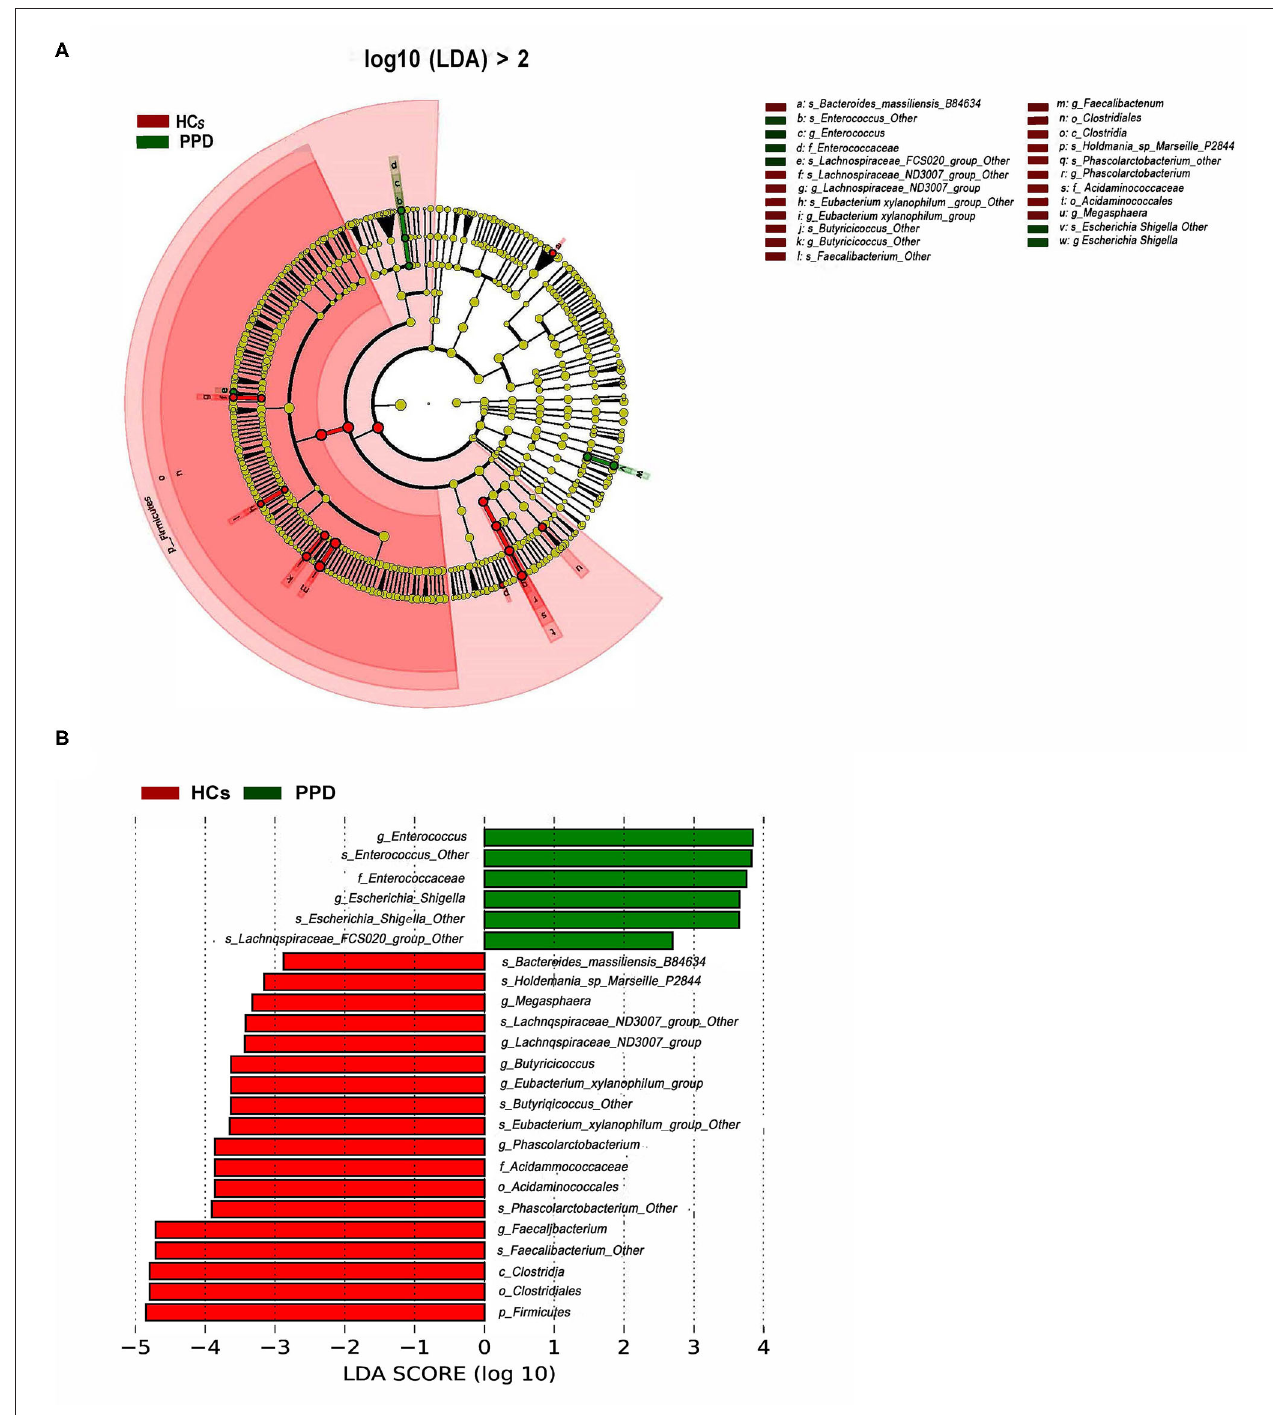
FIGURE 5 | Bacterial taxa differences between healthy control (HC) and postpartum depressive disorder (PPD) patient samples. Cladogram showing the most differentially abundant taxa identified by linear discriminant analysis effect size (LEfSe). Red indicates clades enriched in the HC group, whereas blue indicates clades enriched in the PPD group (A) . Comparisons of gut microbiota between the NC and PPD groups (B) . Only genera meeting a linear discriminant analysis score threshold > 2 are shown.